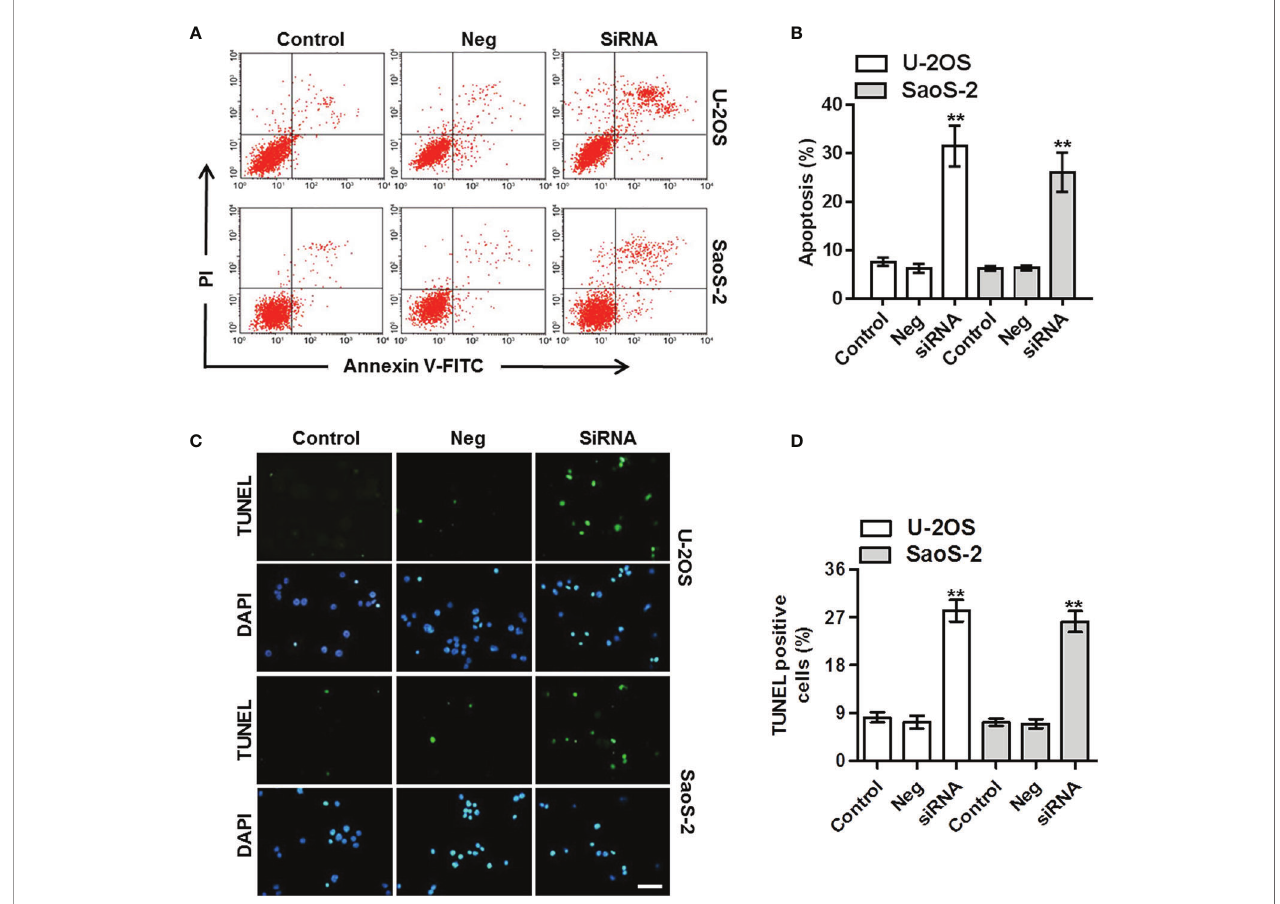
FIGURE 3 | ClC-5 downregulation induces apoptosis in osteosarcoma cells. (A) U-2OS and SaoS-2 cells were transfected with ClC-5 siRNA or negative siRNA (Neg) for 48 h. Cell apoptosis was determined by Annexin V/PI staining. (B) Quantitative analysis of the percentage of apoptotic cells. (C) Apoptosis was also detected by TUNEL staining. Representative images were shown. (D) Quanti fi cation of apoptotic osteosarcoma cells. Scale bar, 20 m m. **P < 0.01 vs. corresponding control, n =